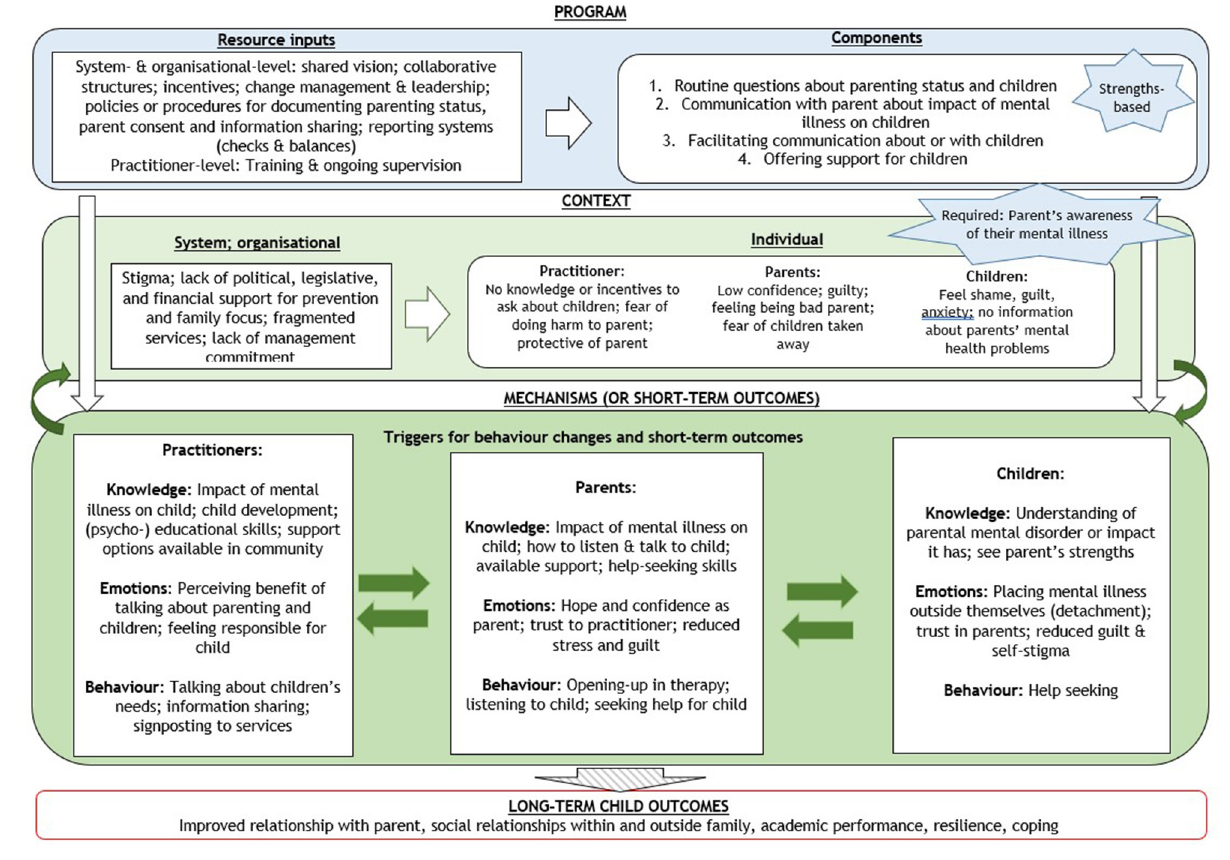
FIGURE 1 | Initial program theory for family-focused